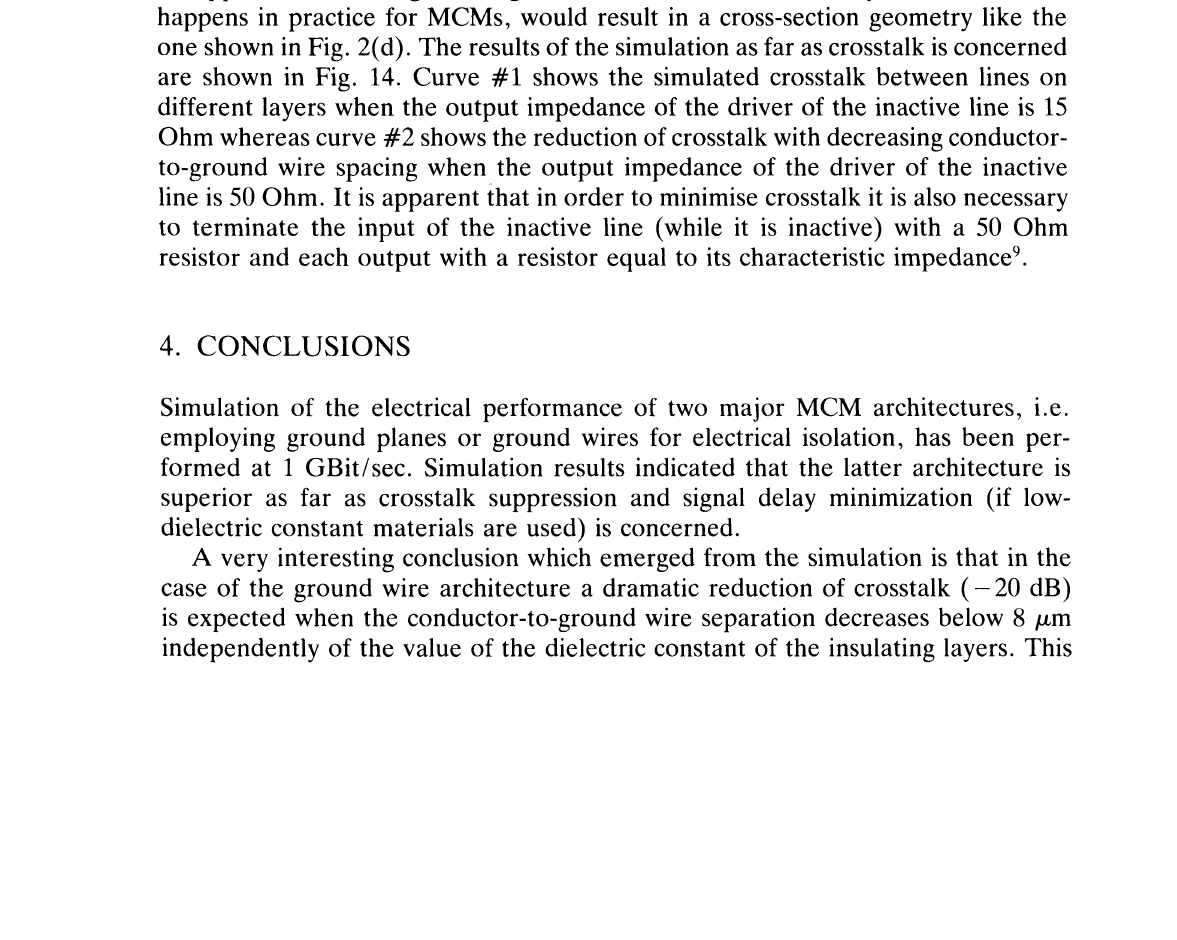
down to 8/xm with a simultaneous neutralisation of the role of the dielectric constant